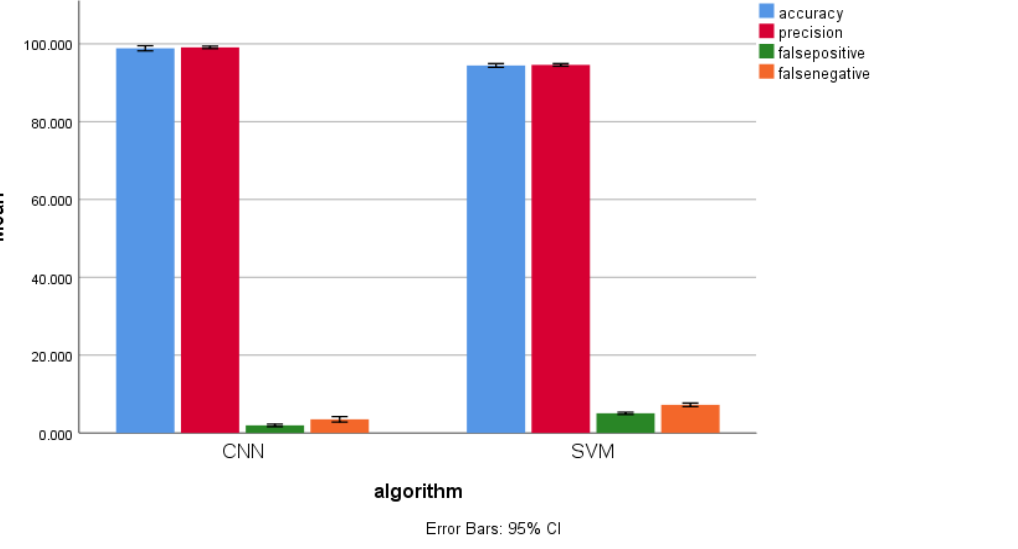
Figure 11. Mean accuracy, mean precision, mean false positive, and mean false negative of the CNN and KNN algorithms’ performance measure with ± 1 standard deviation.